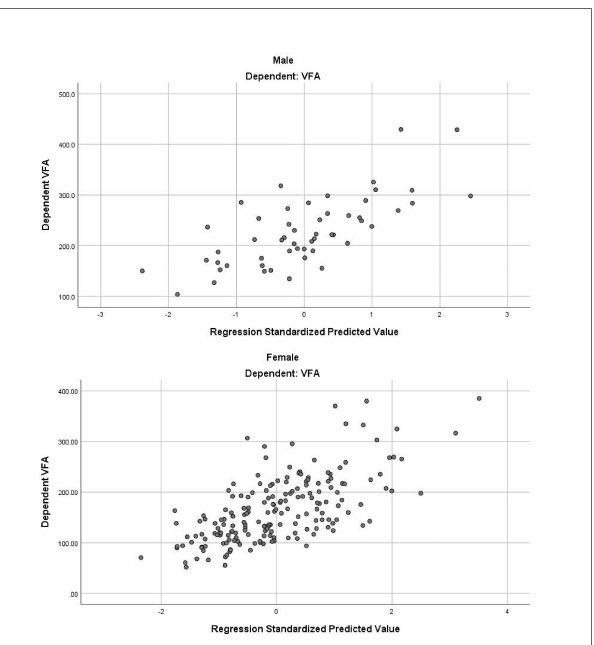
FIGURE 2 | The scatter plot of standardized predicted value and dependent VFA.